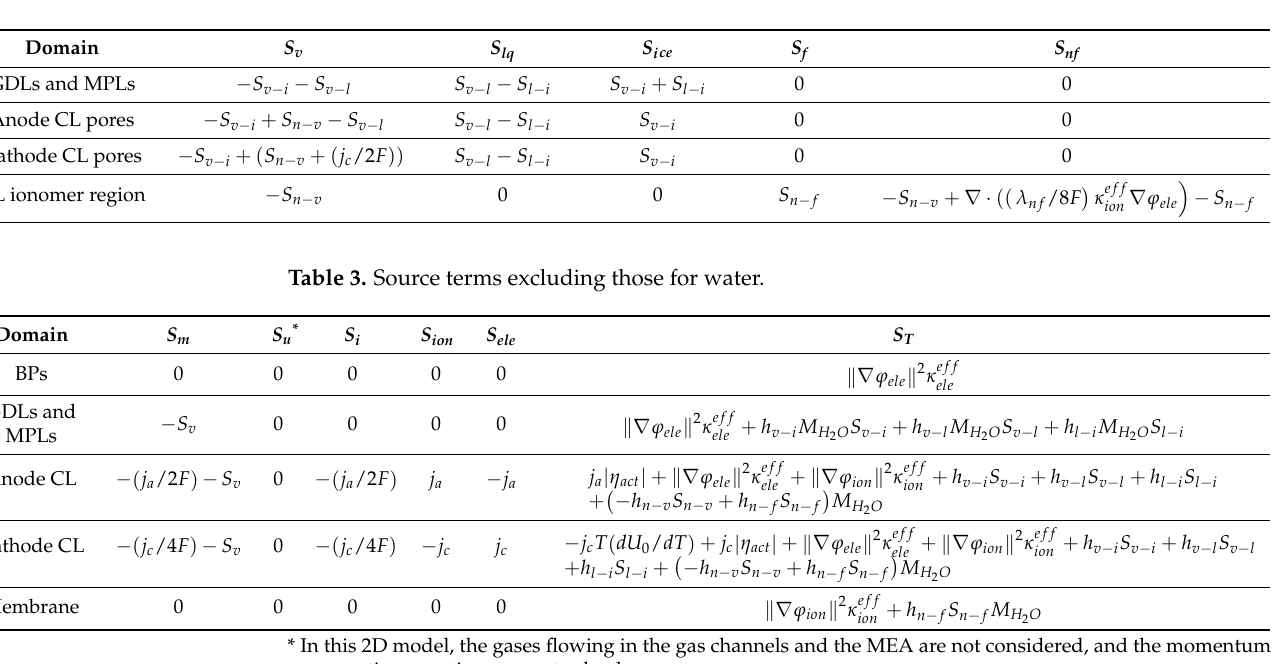
Table 2. Source terms for water.